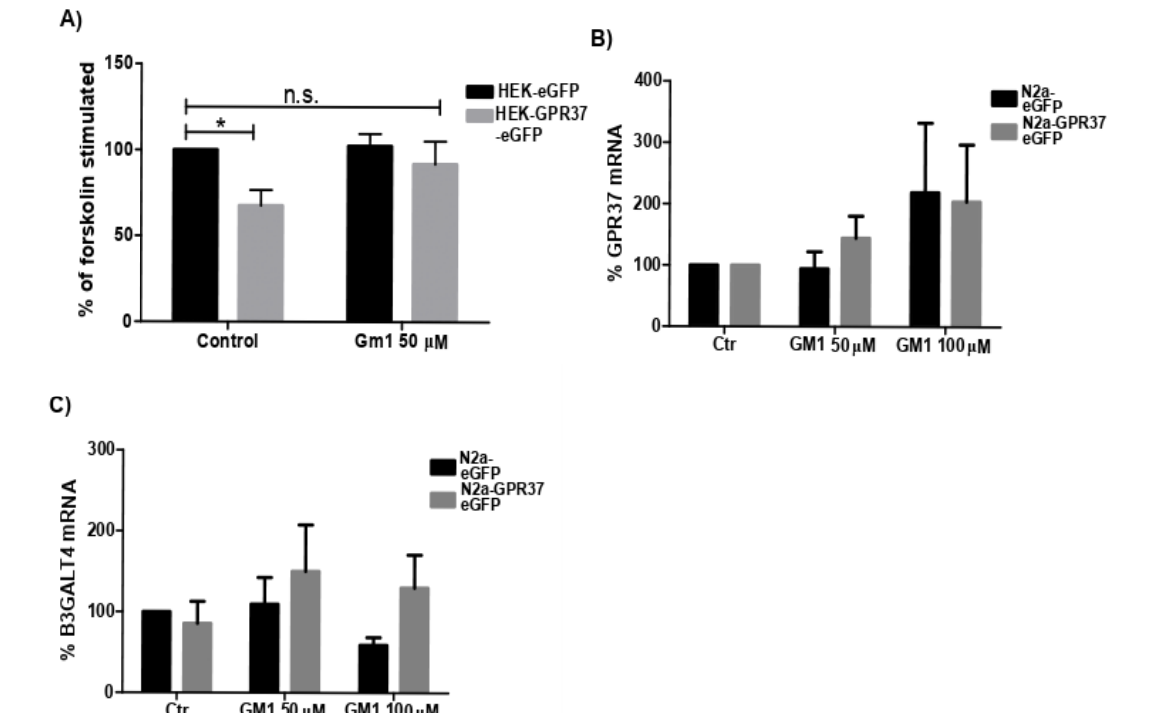
Figure 3. Cellular cAMP level measured by Homogeneous Time-Resolved Fluorescence (HTRF), expressed as percentage of forskolin-stimulated, transiently transfected HEK293T- eGFP , were lower in HEK293T- GPR37-eGFP cells under control conditions. The cAMP level was increased in HEK293T- GPR37-eGFP specifically after 2 h of GM1 treatment, indicating shift in GPCR signaling cascade. n = 3 and data analyzed with two-way ANOVA Turkey post hoc test. ( A ) GPR37 RNA expression levels were not significantly changed due to GM1 treatment compared to baseline of each cell type measured by qPCR. n = 3, data analyzed with Kruskal – Wallis test with Sidak post hoc due to non-normal distribution. ( B ) qPCR of B3GALT4 RNA showed that expression levels were not reduced in N2a GPR37-eGFP at baseline and was not regulated by GM1 treatment. n = 3, data analyzed with two-way ANOVA Turkey post hoc test. ( C ) Error bars indicate SEM * p < 0.05. n.s., non-significant.